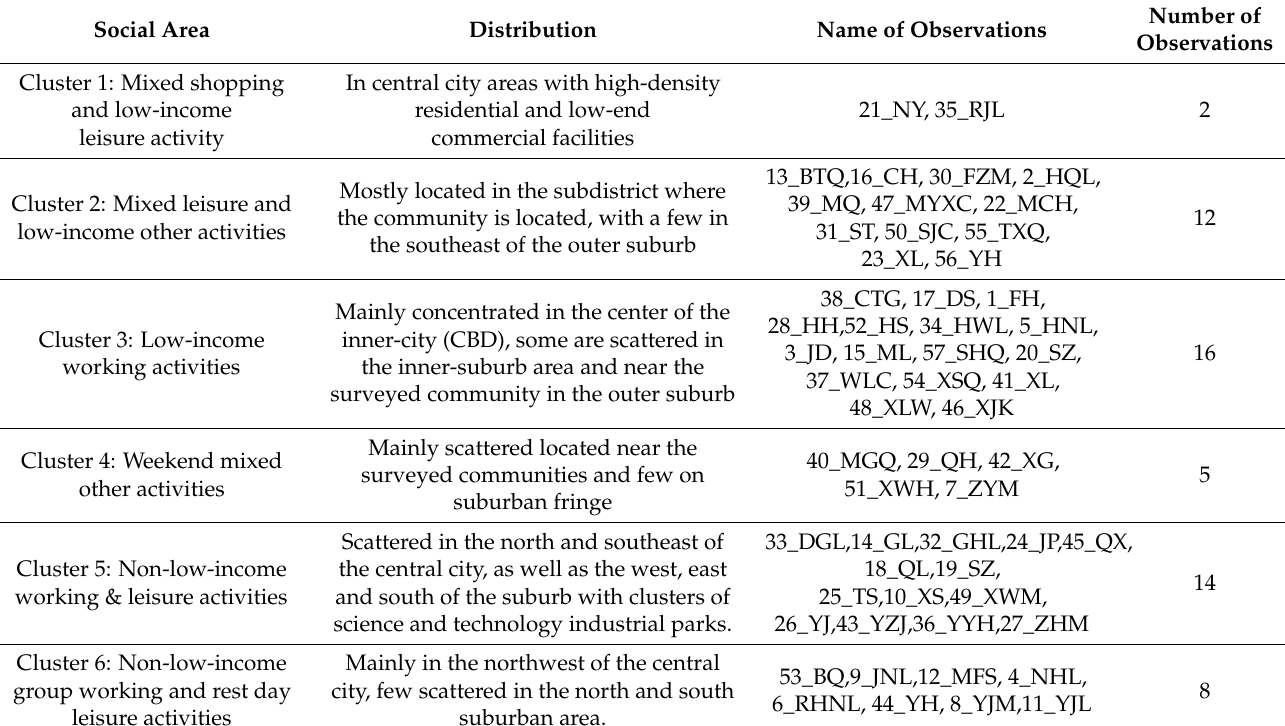
Figure 3. Spatial distribution of activity spaces of different income groups in Nanjing. Table 6. Details of the social areas by activity time distribution of different income